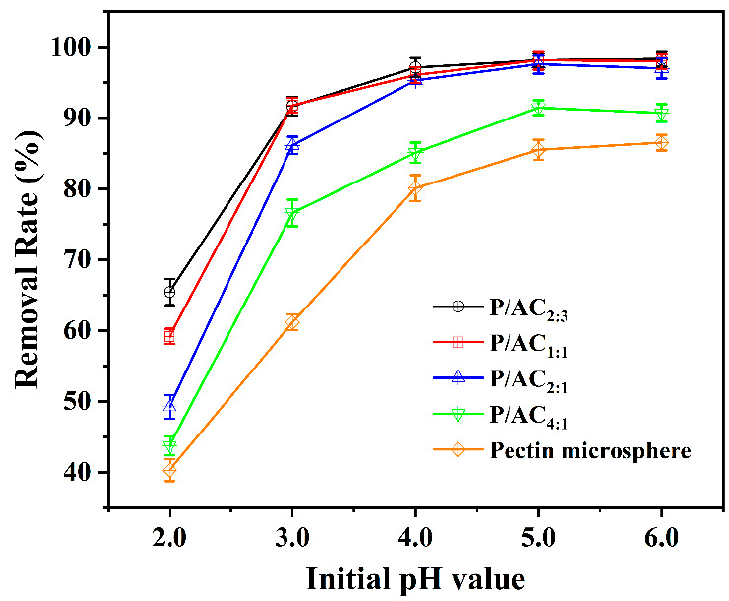
Figure 4. The effect of initial pH (2.0, 3.0, 4.0, 5.0, 6.0) on Pb 2+ adsorption efficiency of P/ACs (adsorbent dosage: 1.0 g/L, initial Pb 2+ concentration of 50 mg/L, temperature of 298 K, contact time of 1440 min).